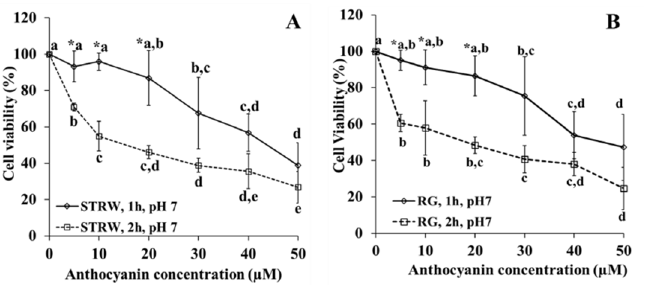
Figure 1. The effect of the concentration of strawberry ( A ) and red grape ( B ) anthocyanin on cytotoxicity at pH 7, incubation for 1 and 2 h at 37 °C. STRW = strawberry, RG = red grape. * Indicates significant difference ( p < 0.05) for comparison at the same concentration but at different time of incubation. Lower case letters compare values for the same time of incubation at different concentration, with different letters in the compared values denoting significant difference at p < 0.05. At 1 h of exposure, no difference in toxicity was observed until 20 µ M of anthocyanins either in strawberry or red grape. Consequently, to compare the extent of anthocyanin uptake from strawberry and red grape, the highest concentration at 20 µ M was